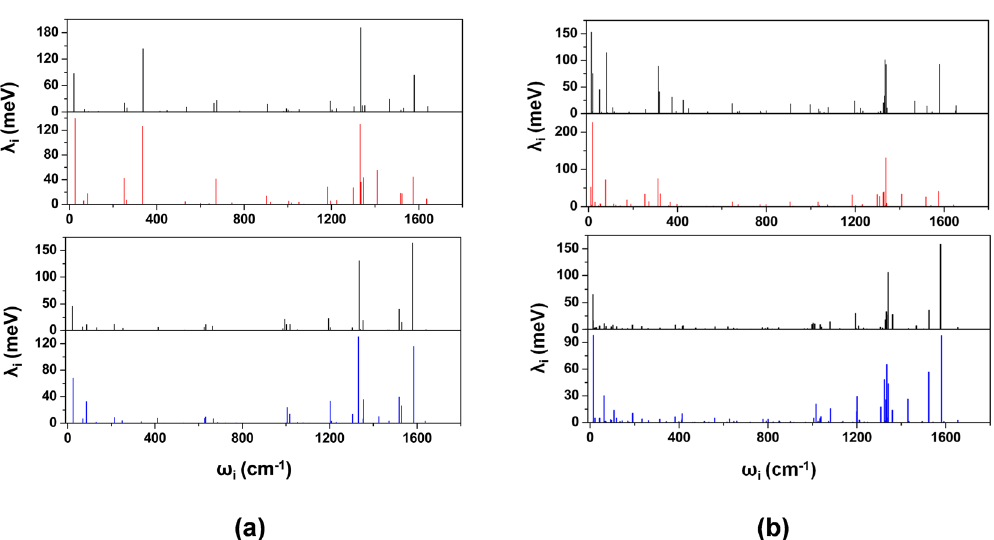
Figure 2. ( a ) Frequency dependence of reorganization energies for neutral and anionic rubrene upon electron- transfer process (top) and for neutral and cationic rubrene upon hole-transfer process (below); ( b ) Frequency dependence of reorganization energies for neutral and anionic fm-rubrene upon electron-transfer process (top) and for neutral and cationic fm-rubrene upon hole-transfer process (below); the black lines represent neutral compounds, the red lines represent anionic compounds, and the blue lines represent cationic